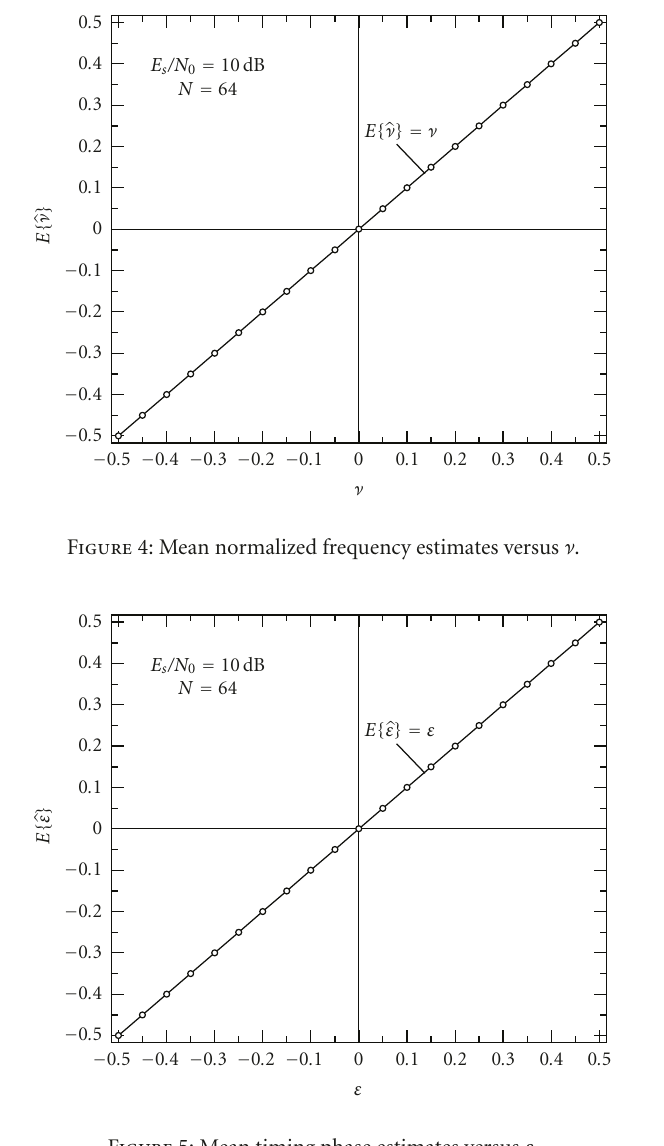
Figure 5: Mean timing phase estimates versus ε .